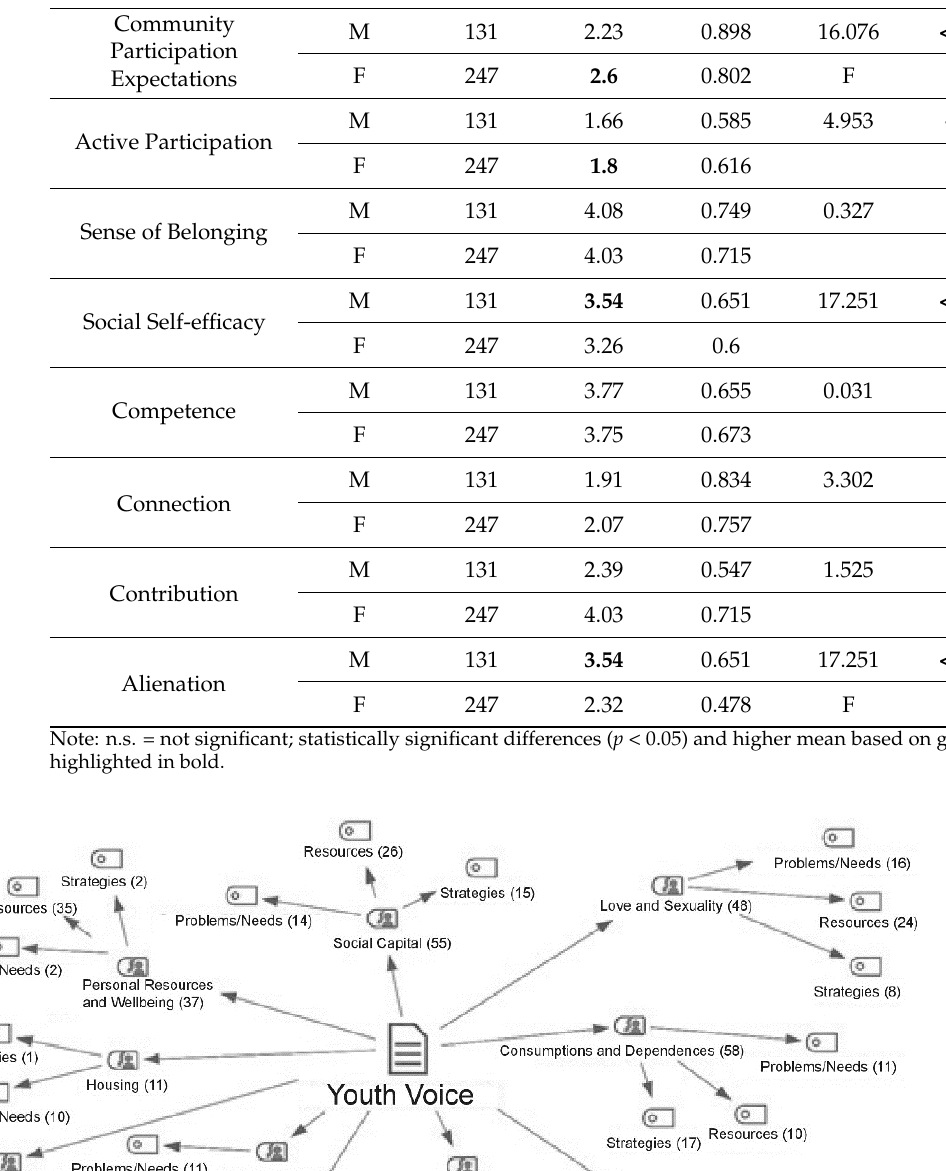
Table 1. Anova comparisons according to gender adapted [32].